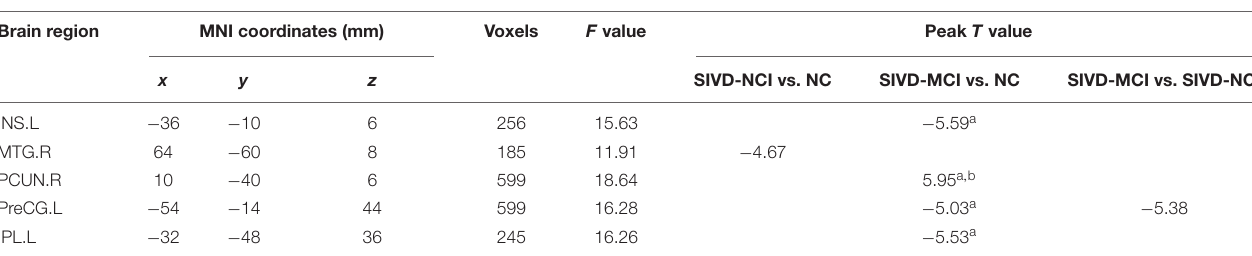
FIGURE 2 | Brain regions of group differences in ReHo/CBF ratio values controlling for age gender and education (cluster-level P < 0.05, FDR corrected, cluster-forming threshold at voxel-level P < 0.001); x , y , z , coordinates of primary peak locations in MNI space; INS, insula; MTG, middle temporal gyrus; PCUN, precuneus; PreCG, precentral gyrus; IPL, inferior parietal, but supramarginal and angular gyri; L, left; R, right. The color bar represents the F values. TABLE 3 | Group differences in the value of the ReHo/CBF